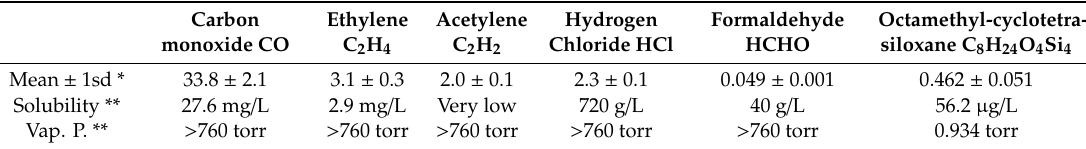
Table 3. Concentrations (ppmv) of very volatile compounds in the burning PVC pipes emissions analyzed by infrared